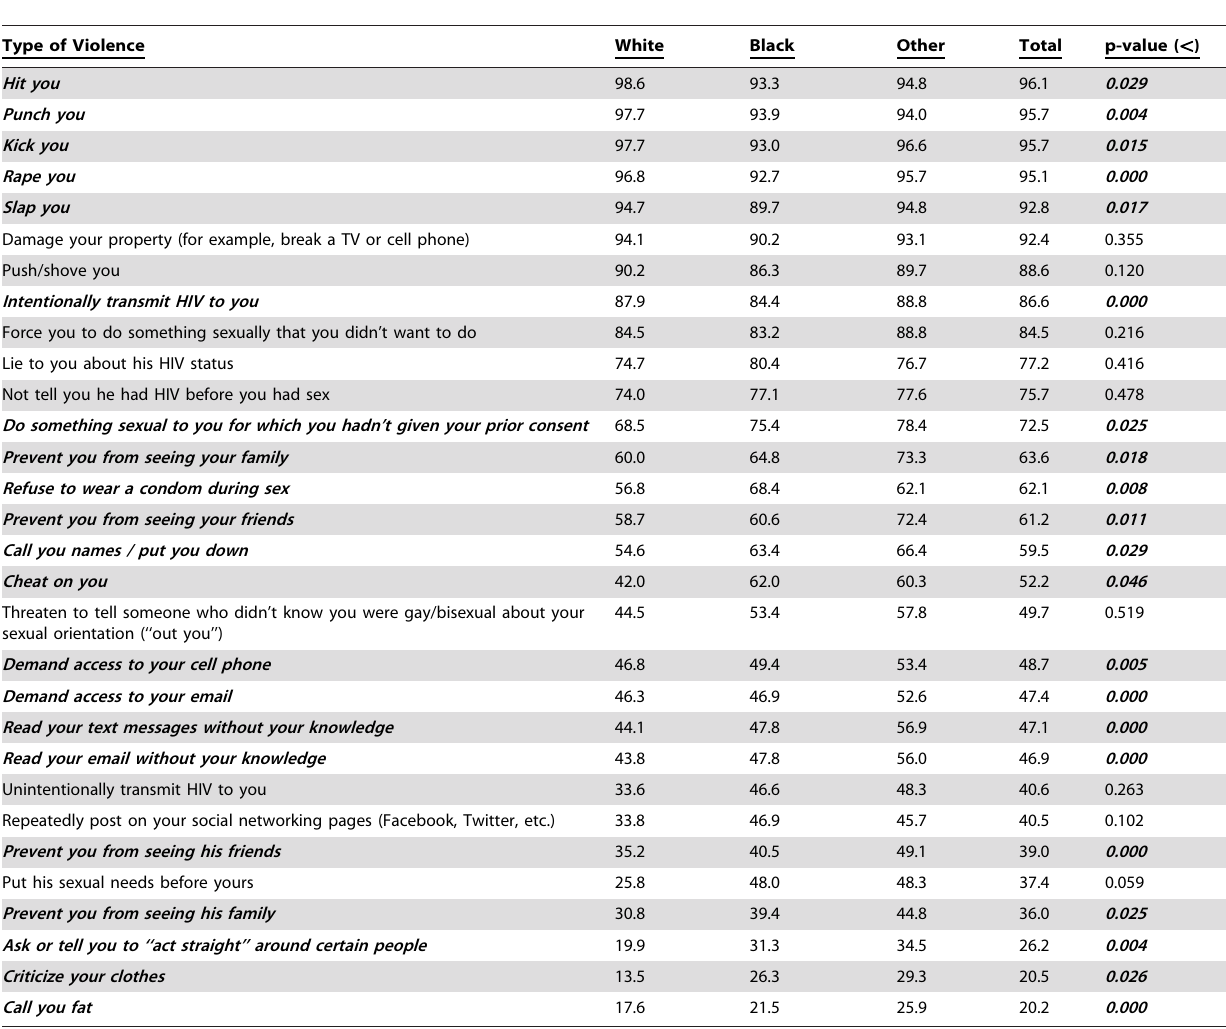
Table 2. Percentage of gay and bisexual men agreeing that each statement was a form of intimate partner